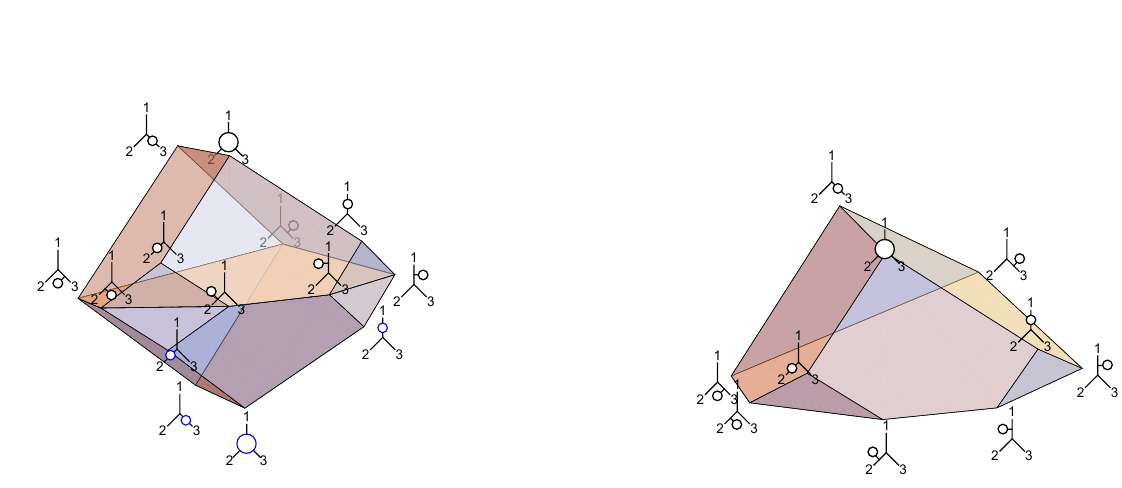
Figure 18 . The cluster polytope D 3 (left) and the new polytope D 3 (right).